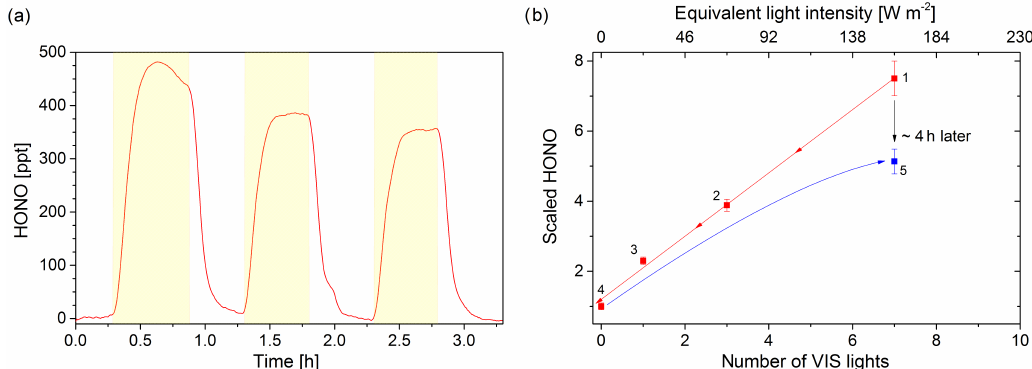
Figure 4. Light-induced HONO formation on BSA. (a) HONO formation under alternating dark and light conditions on BSA surface (22.5µgcm − 2 ); yellow shaded areas indicate periods in which seven VIS lamps were switched on (RH = 50%, NO 2 = 20ppb). (b) Depen- dency of HONO formation on radiation intensity at 20ppb NO 2 and 50% RH (BSA = 31 . 4µgcm − 2 ). The experiment started with seven VIS lights switched on, sequentially decreasing the number of lights (red symbols, nominated 1–4), prior to applying the initial irradiance again (blue symbol, 5). HONO was scaled to the HONO concentration in darkness ([HONO] lights / [HONO] dark ). Error bars indicate SD of 20–30min measurements; SD of point 5 covers 2.75h measurement.